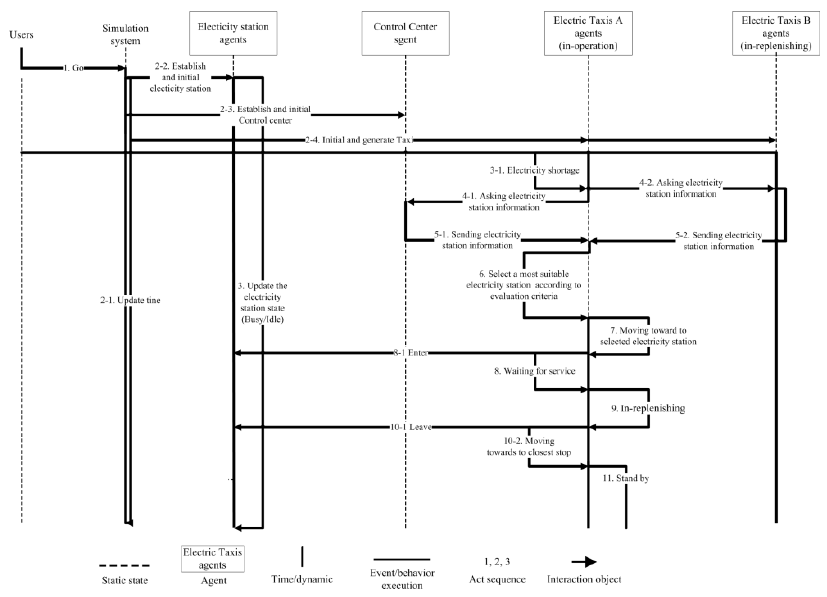
Figure 11. “ Electricity replenishing interaction